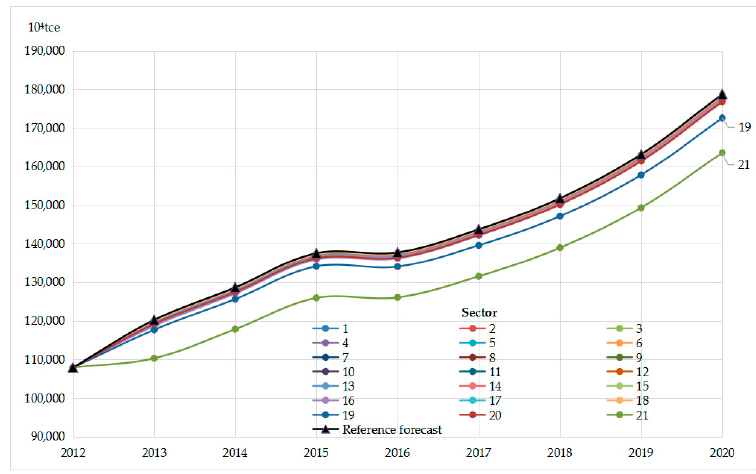
Figure 6. EECS in the sensitivity analysis of the positive capital coefficient.